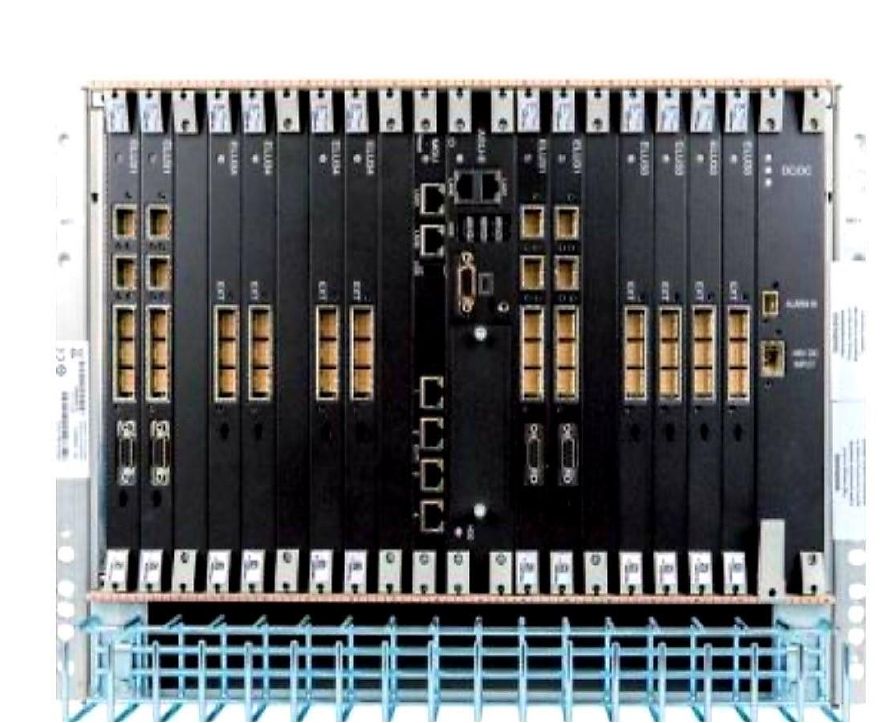
Figure 3 – Appearance of the 7U cabinet of the Media Gateway LIM type MX-ONE Classic (with the MGU2 board) from the composition of the MX-ONE Service Node 6.0